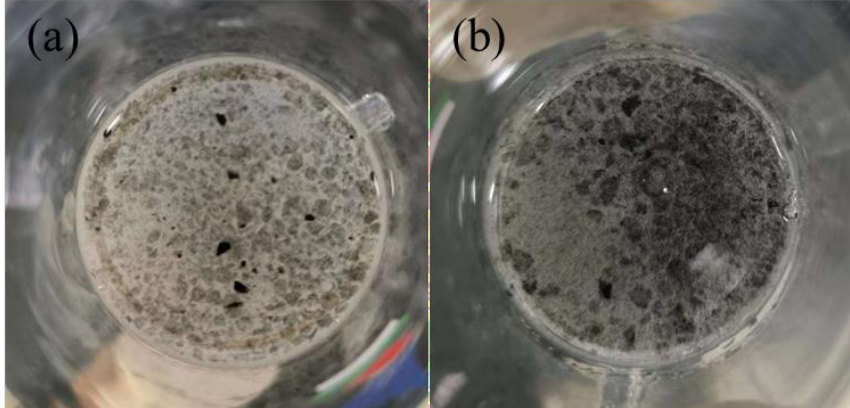
Figure 5. The swelling phenomenon of SPA composites in concentrated sulfuric acid: ( a ) SPA-1.0 wt% GO, ( b ) SPA-2.0 wt% GO. Table 2. Gel content and intrinsic viscosity data of SPA